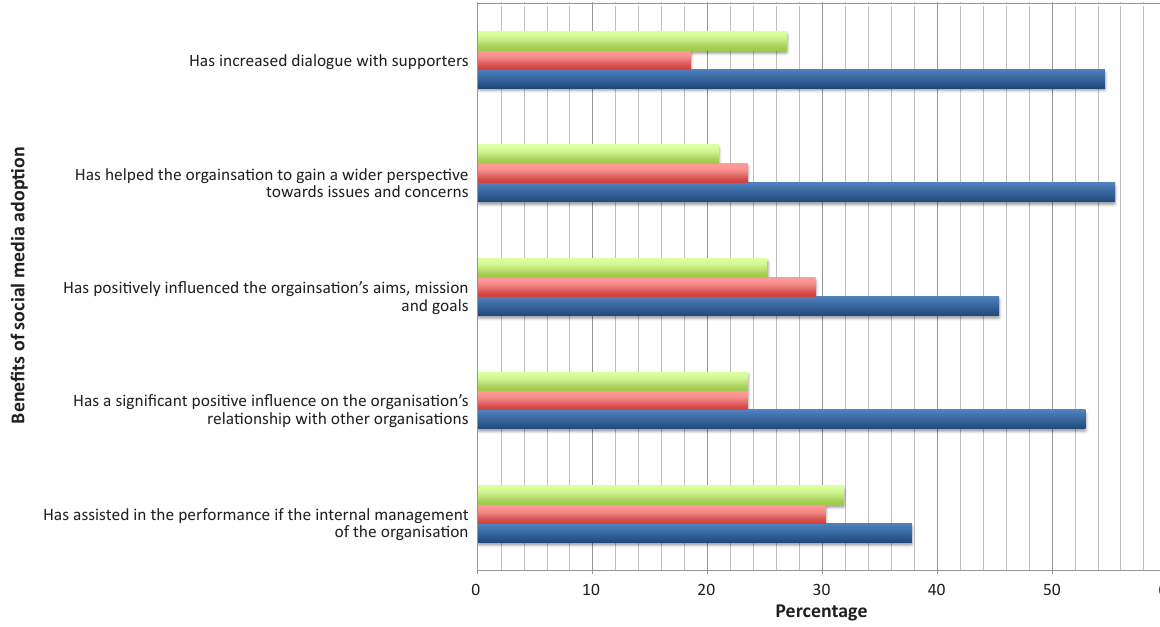
FIGURE 5: Perceptions on the use of Web